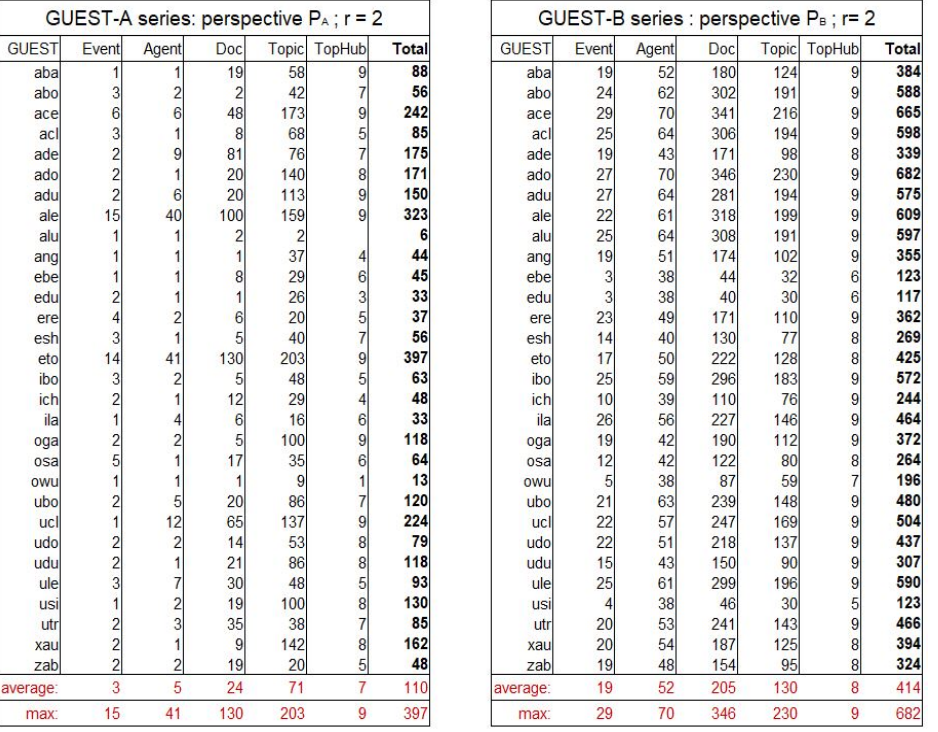
Figure 13. An overview of the GUEST - A and GUEST - B